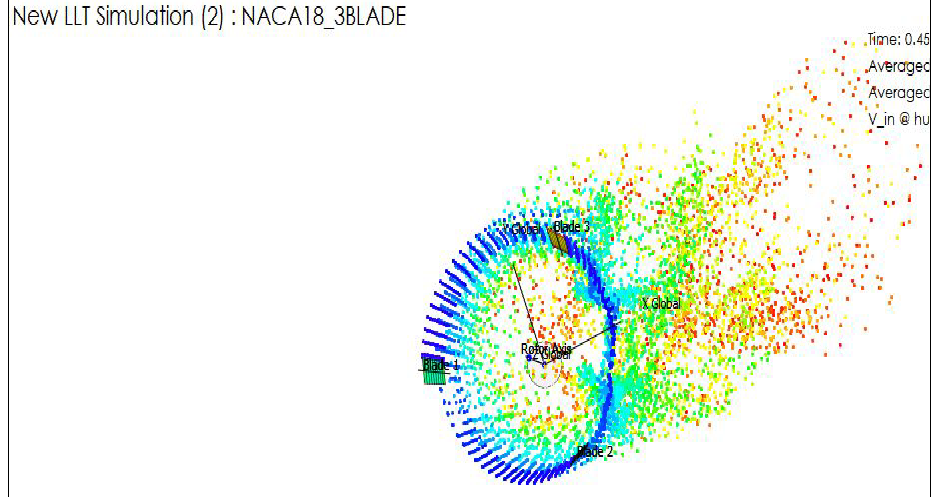
Figure 51. No shredding and trailing vortex